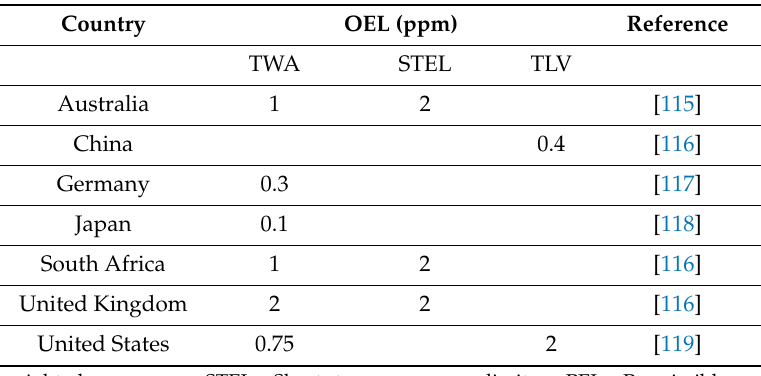
Table 4. The permissible limit of formaldehyde in various